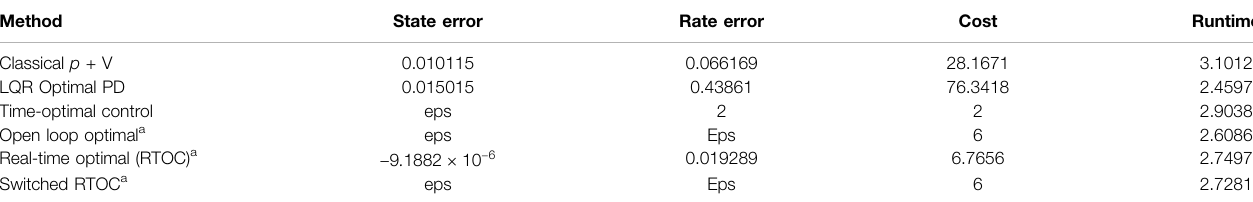
TABLE 9 | Double-integrator plant (no transport theorem) with control design based off double-integrator (no transport theorem): quantitative comparative data corresponding to the qualitative display in Figures 3A,B